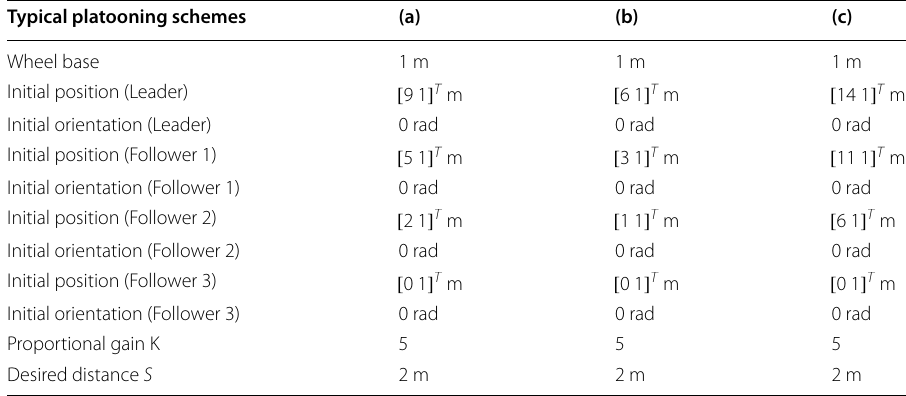
Table 1 Vehicle parameters Typical platooning schemes (a) Wheel